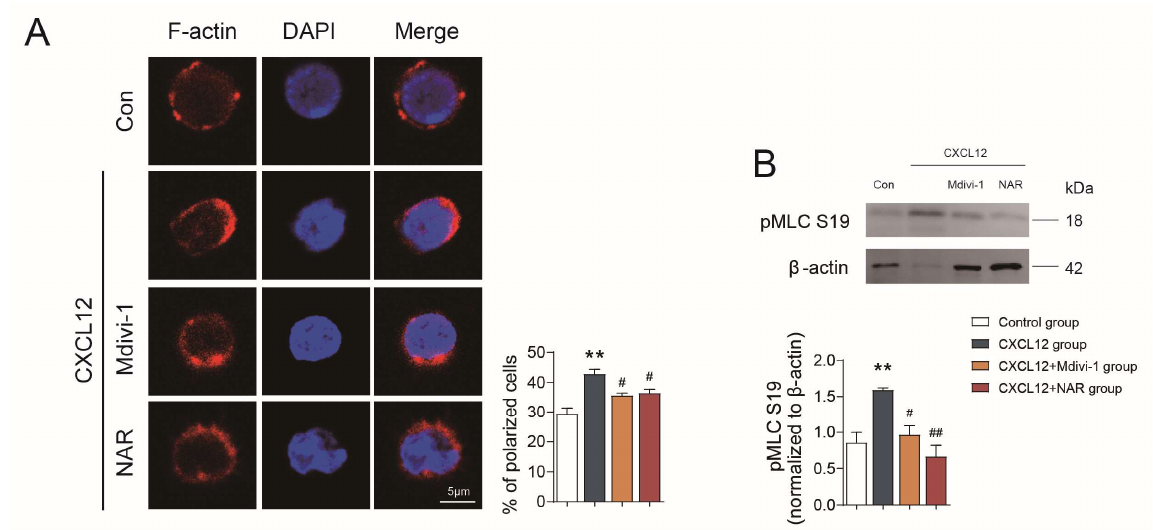
Figure 6. NAR inhibited the polarization of primary CD4 + T lymphocytes. ( A ) F-actin of CD4 + T lymphocytes measured by immunofluorescence. ( B ) Representative western blots showing the expression of pMLC in the CD4 + T lymphocyte in different groups. ** p < 0.01 vs. control group, # p < 0.05, ## p < 0.01 vs. CXCL12 group, by repeated-measures one-way ANOVA followed by post hoc Dunnett’s multiple comparisons test. All scale bars are 5 µm. The data are presented as means ± SEM (n = 3 mice per group).